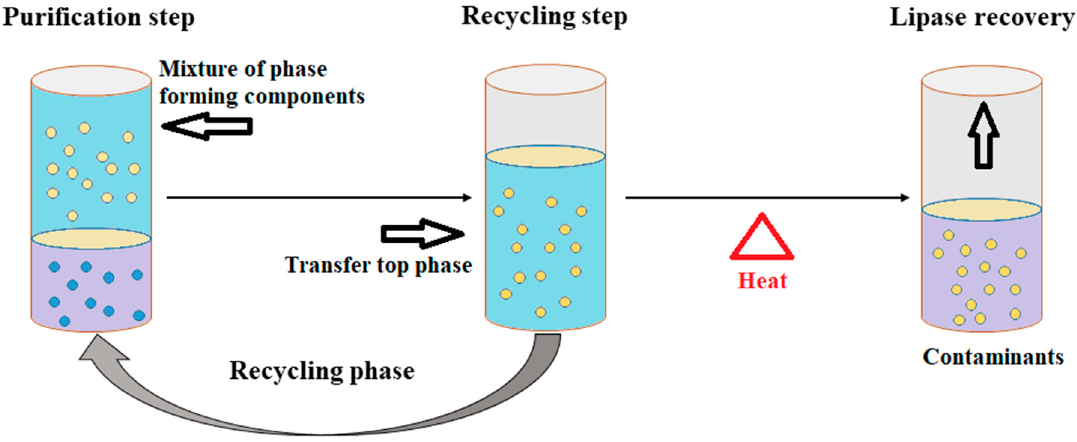
Figure 3. Schematic presentation of an aqueous two-phase system (ATPS) for lipase purification.